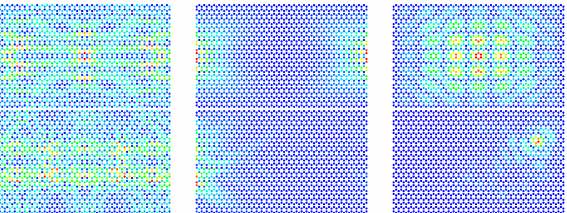
Figure 10. Wave functions in the hexagonal lattice with rectangular shape with 1656 sites (24 rows of 34 and 35 sites, respectively) with minimal participation ratios at the vHs − ( left column ), the vHs + ( middle column ) and at the peak in the density of states ( right column ) emerging at the upper band edge for | λ ( II ) / λ ( I ) | (cid:38) 0.25. They are shown for | λ ( II ) / λ ( I ) | = 0.2. At the vHs − , the wave function is localized along interior zigzag edges, whereas, for the upper one vHs + , it is strongly localized at the armchair edges. The upper row shows wave functions for the noiseless case, the lower one with noise. Localization is considerably enhanced in the latter